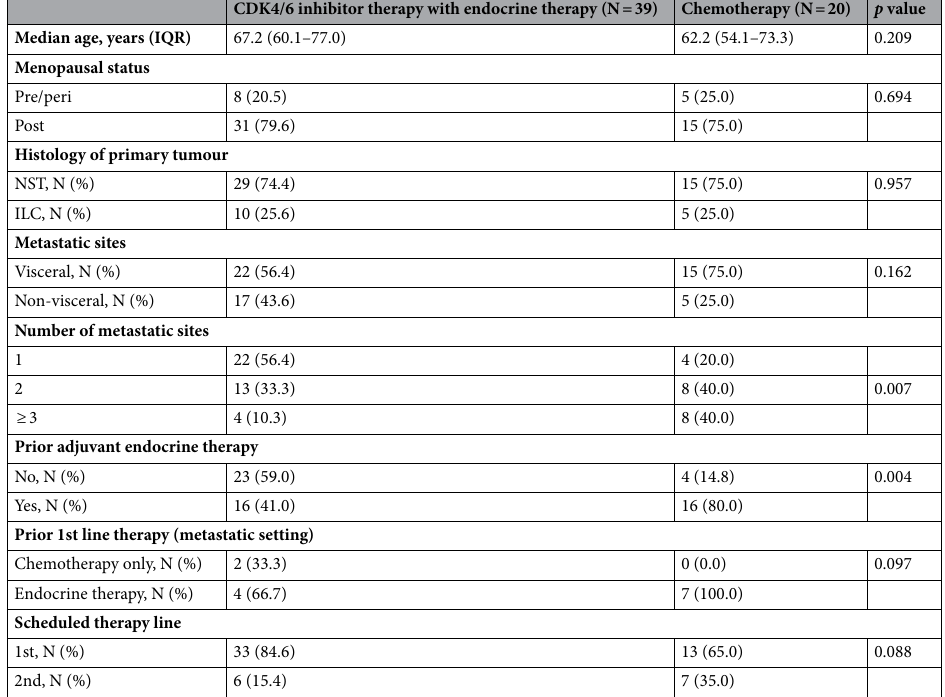
Table 1. Basic clinical and clinicopathological characteristics stratified by scheduled therapy. Abbreviations: IQR, interquartile range; NST, Invasive carcinoma of no special type; ILC, invasive lobular